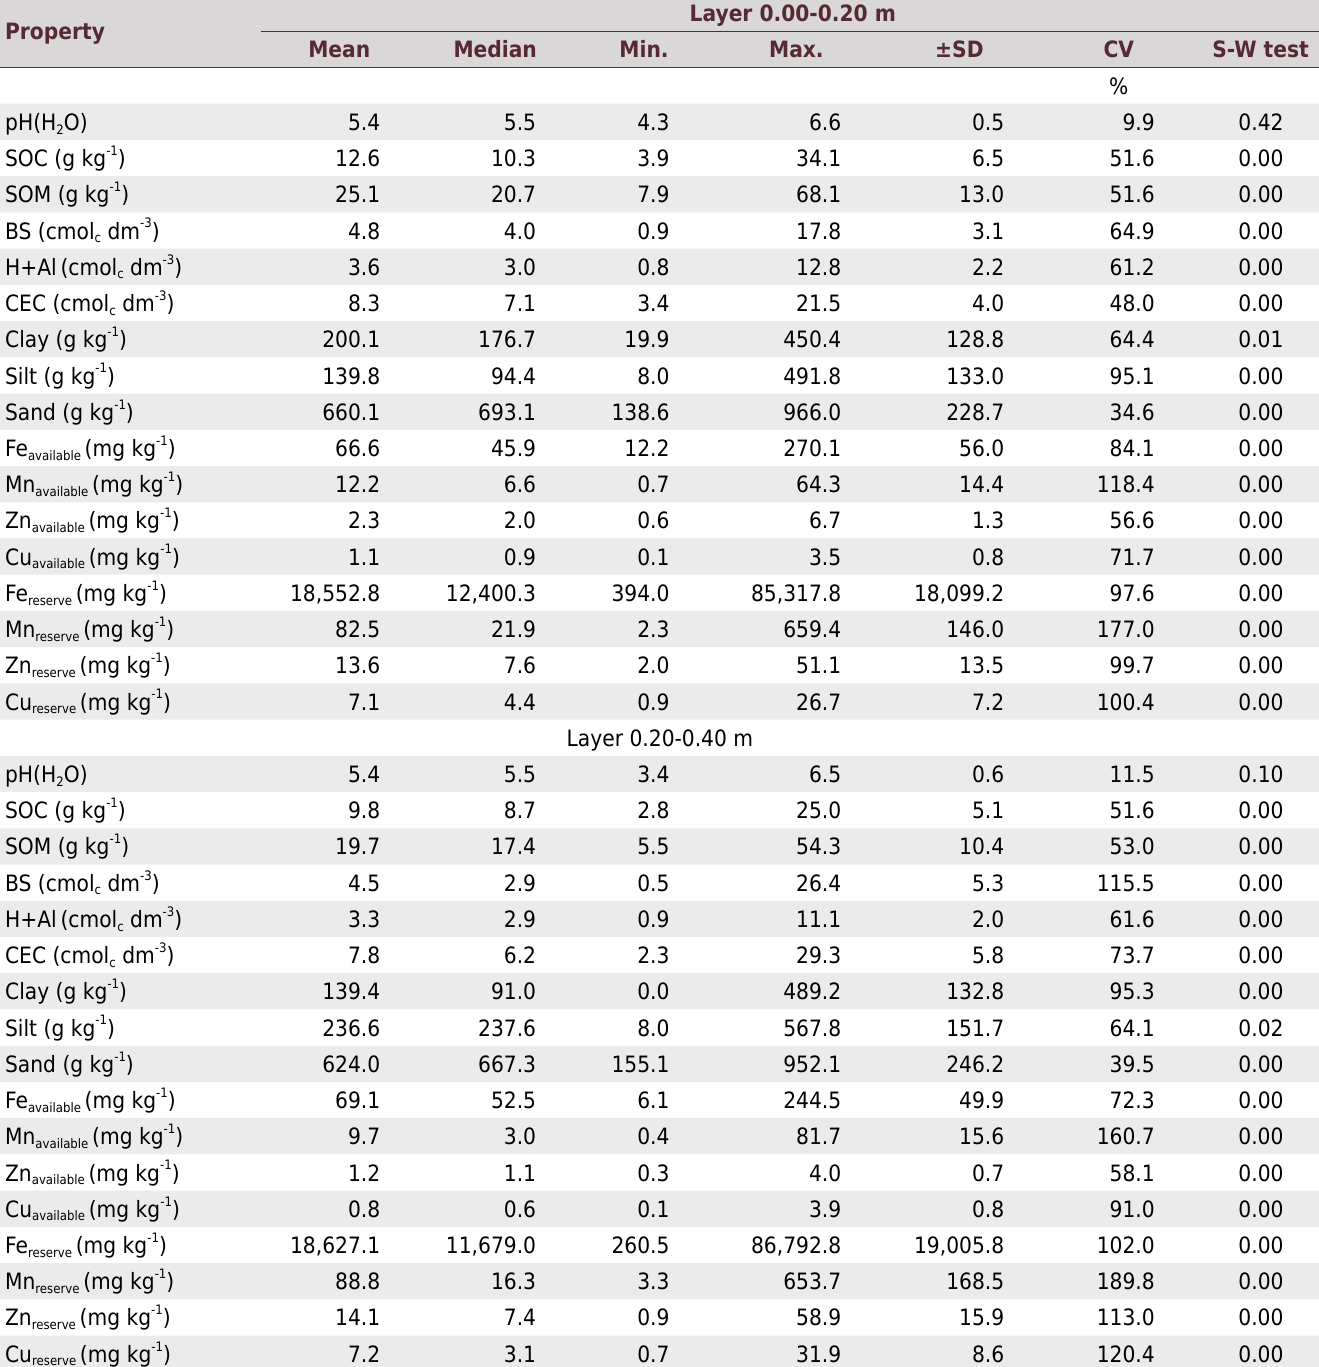
Table 1. Descriptive statistic for soil chemical and physical properties and micronutrient contents in soil